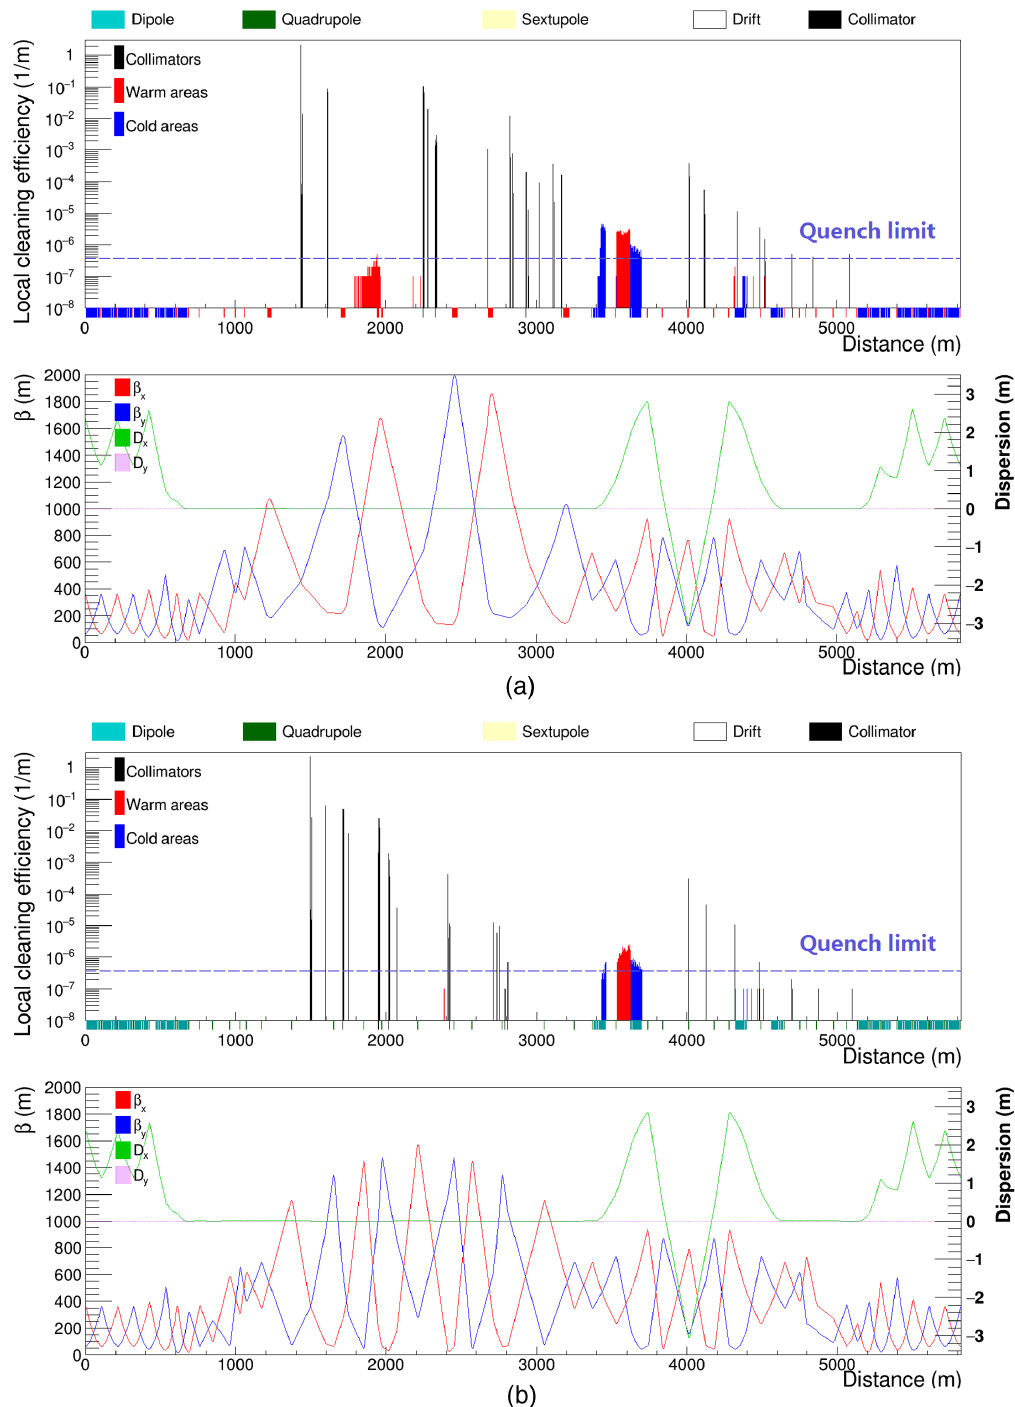
FIG. 8. Proton loss maps in the collimation insertion with an initial vertical halo distribution, using lattice scheme I (a) and II